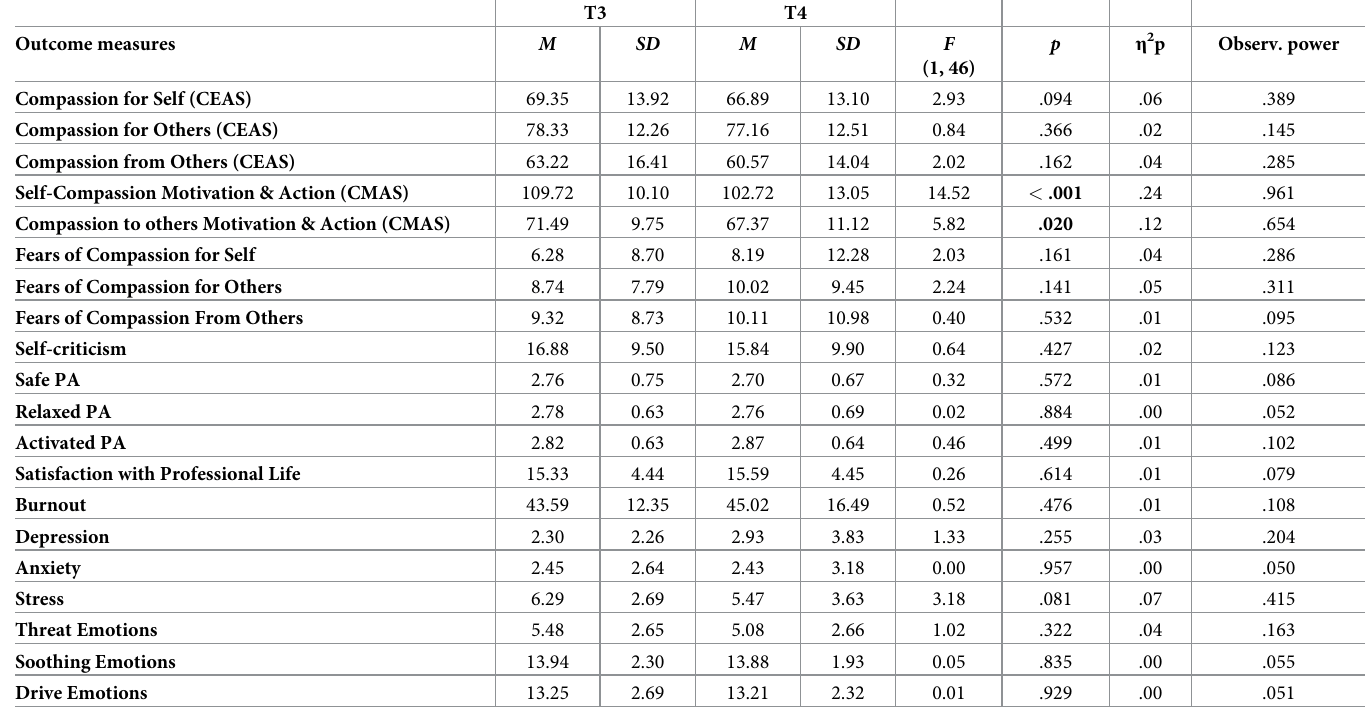
Table 7. Mean comparisons at post-CMT-T (T3) and 3-months follow-up (T4), effect size and observed power ( N =